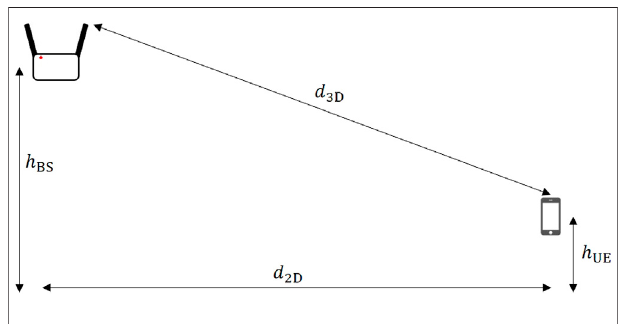
FIGURE 5 | De fi nition of d 2D and d 3D for indoor scenarios.